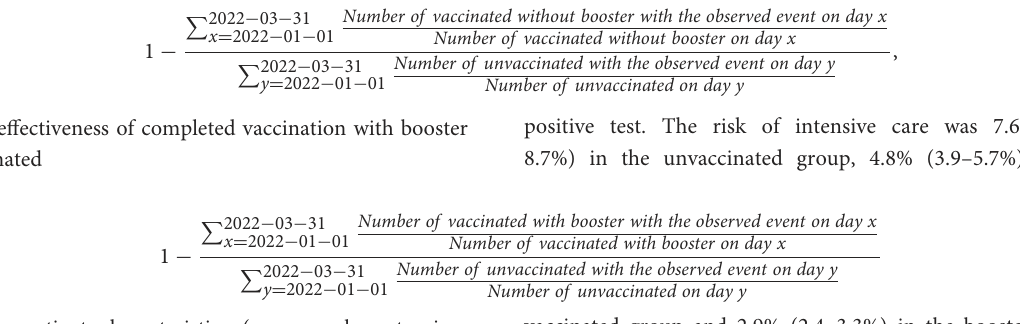
TABLE 1 Comorbidities and medication of patients with chronic heart failure diagnosed with COVID-19 from January to March 2022. Total